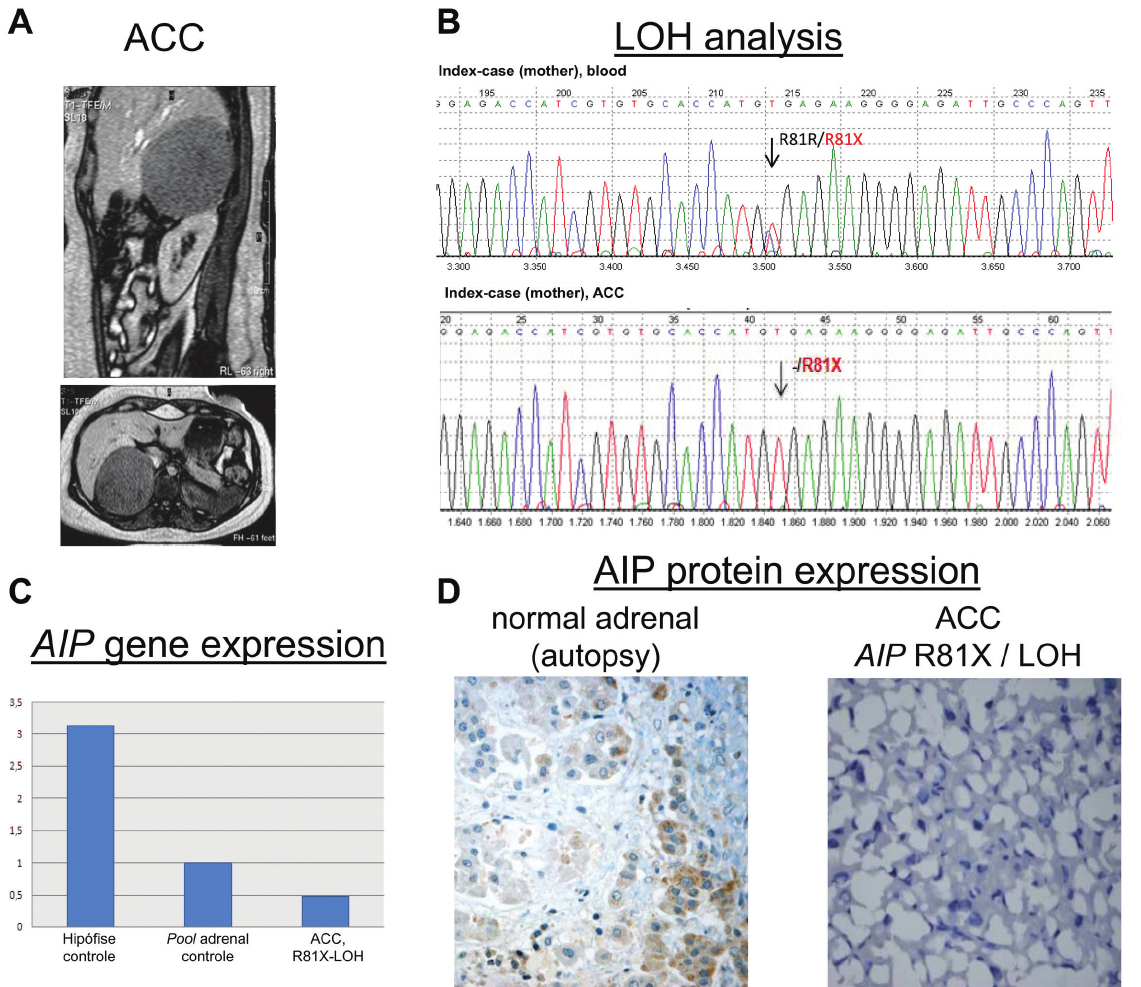
histopathologically classified as adrenocortical carcinoma. B - Sequence and microsatellite (D11S1258 AIP -flanking marker) analyses of DNA samples from the tumor revealed loss of the wild-type AIP allele. C - The 2 - ΔΔ CT method was used to compare AIP mRNA expression in pooled normal pituitary glands